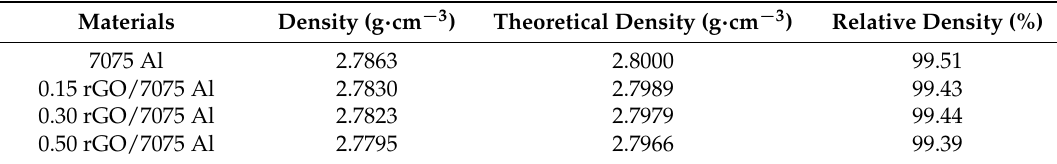
Figure 11. The variation tendencies of ( a ) hardness and ( b ) yield strength, and the ultimate tensile strength with rGO content. Table 2. Densities of 7075 Al and rGO/7075 Al.